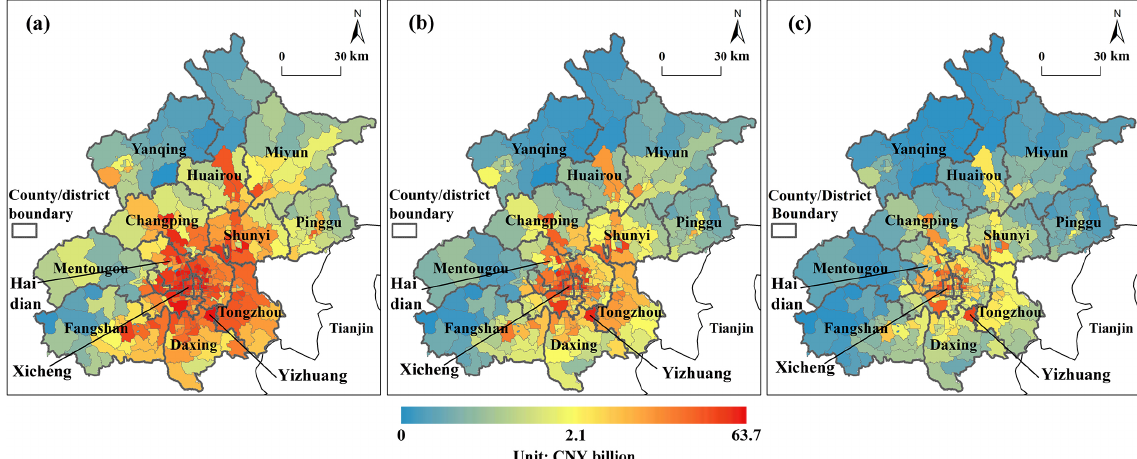
Figure 6. Evaluation results of the indirect economic loss of the streets, villages, and towns of Beijing (BJ) under the different rescue scenarios. (a) Scenario A; (b) Scenario B1; (c) Scenario